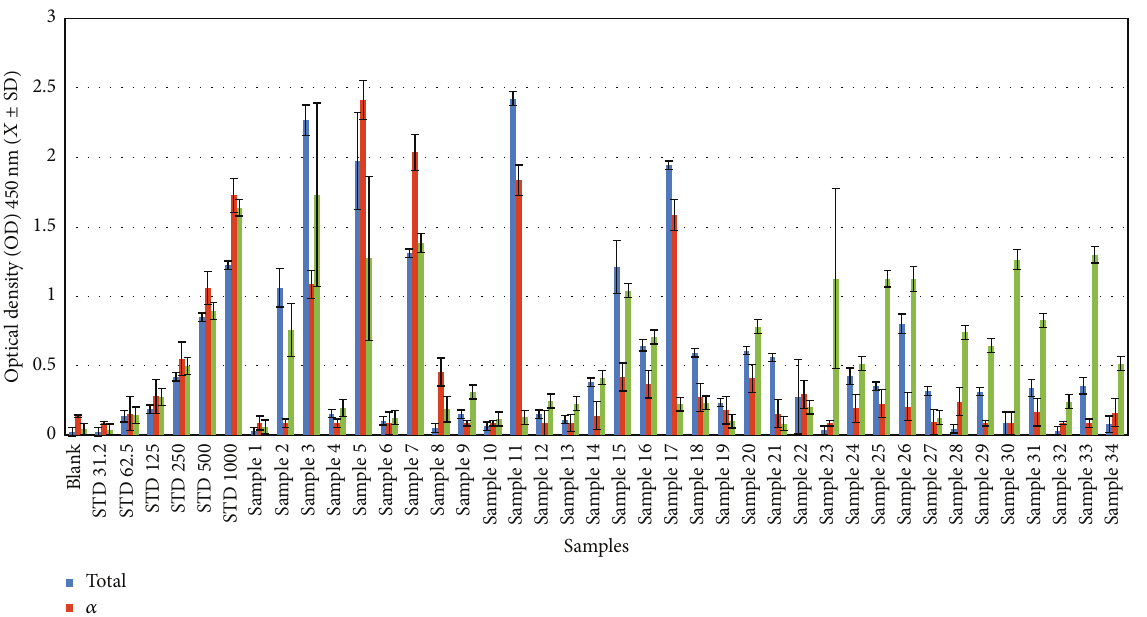
Figure 4: Comparison of concentration distribution of human (total, 𝛼 , and 𝛽 ) defensins in patient sera.